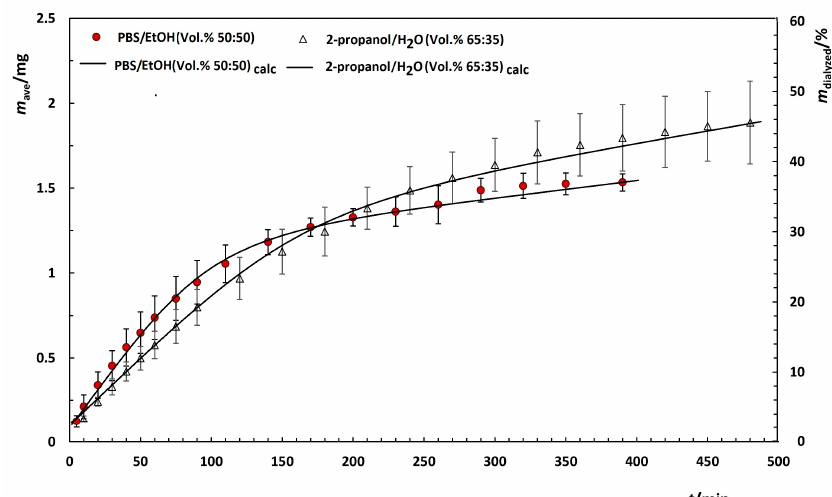
Figure 4. The cumulative mass of the quercetin through dialysis membranes with MWCO of 25 kDa in PBS/EtOH (Vol.% 50:50) and 2-propanol/H 2 O (Vol.% 65:35) at 37 ◦ C with single exponential decay fit (left ordinate) and fraction of dialyzed quercetin relative to the total mass of quercetin in dialysis bag at t = 0 (right ordinate).